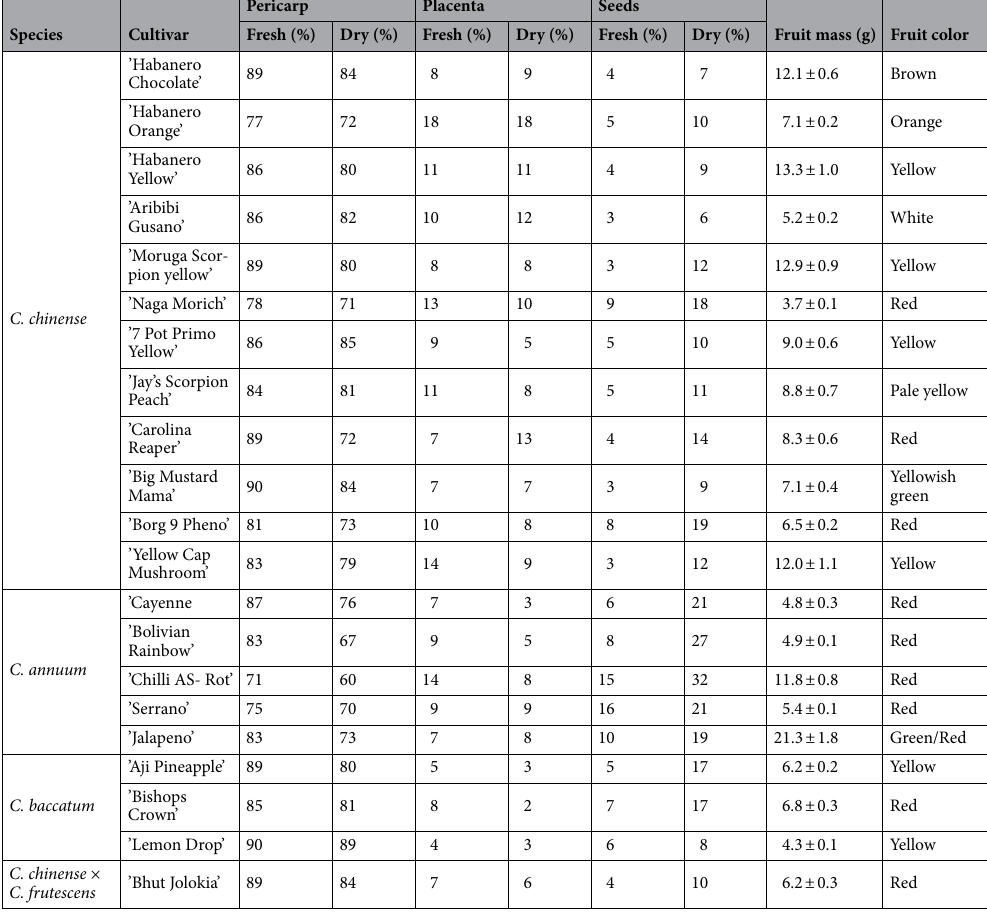
Table 1. Fruit characteristics in different species and